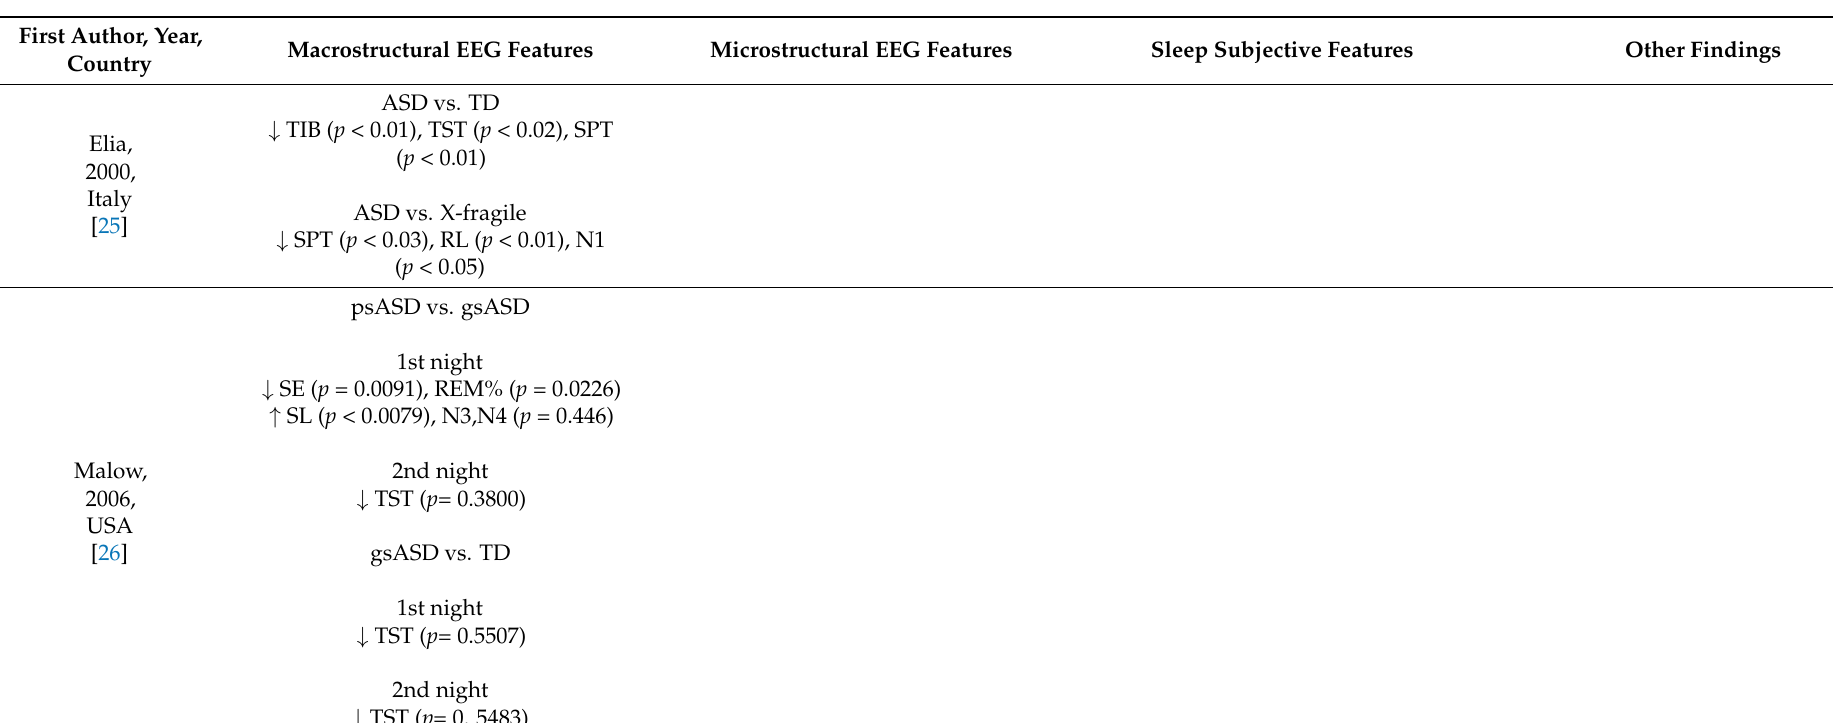
Table 2. Main significant findings, with p -value in